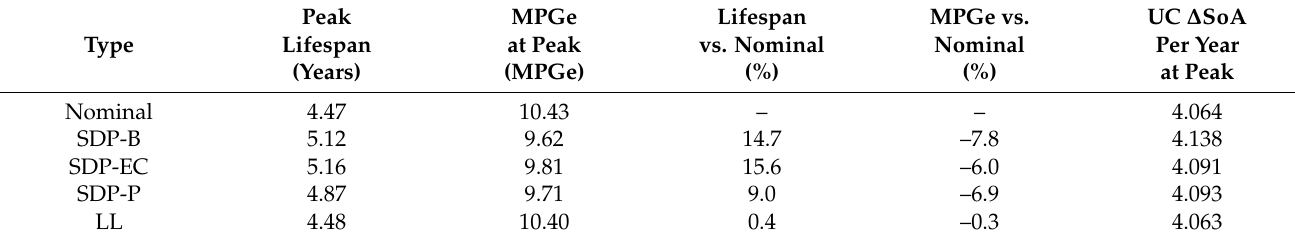
Table 6. Comparison of Causal Controllers, mid-sized HESS ( N pc = 40).